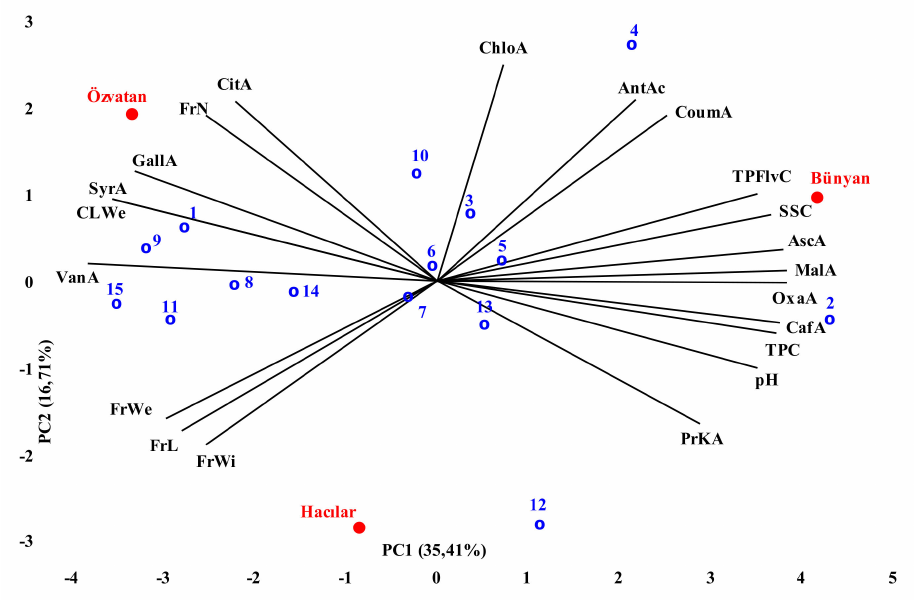
Figure 1. Biplot of first two PCs according to locations, genotypes and quality parameters